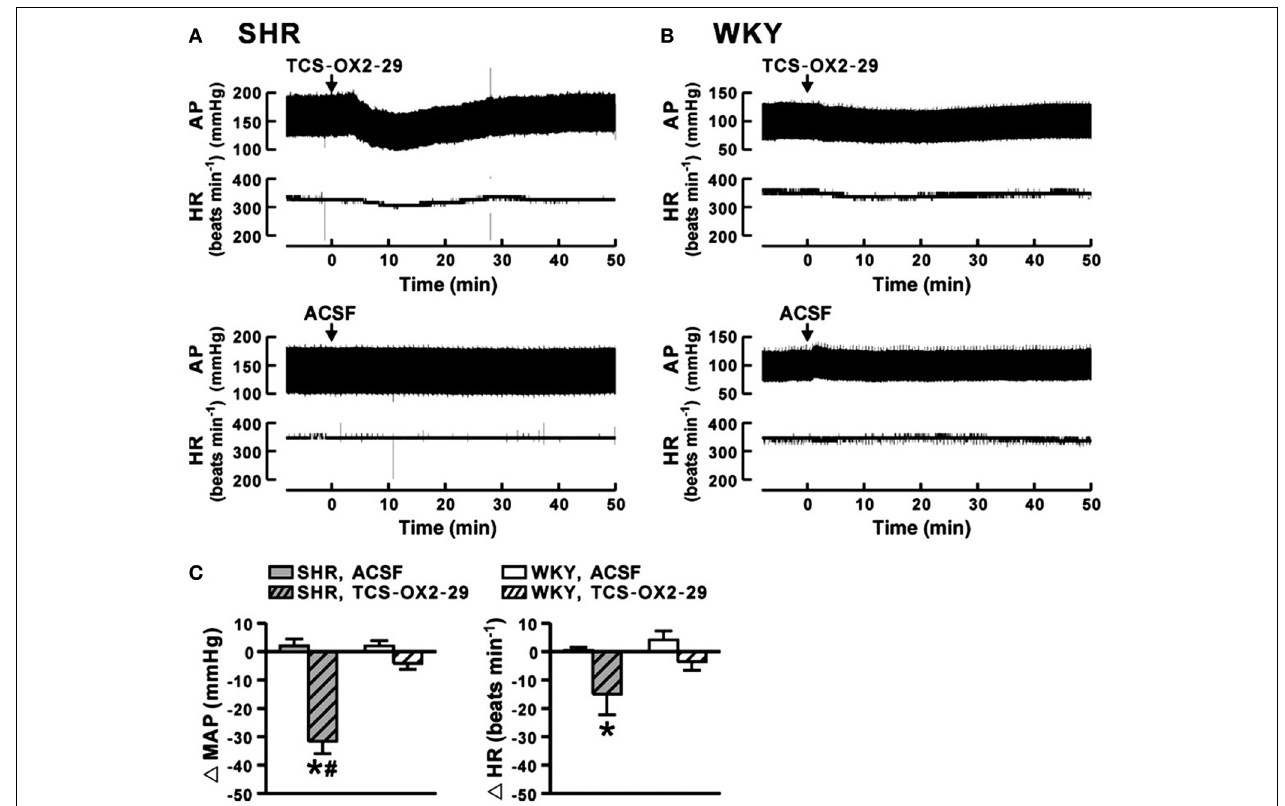
FIGURE 7 | In anesthetized SHR, antagonism of OX 2 R in RVLM decreases arterial pressure. Microinjection of an OX 2 R antagonist (TCS-OX2-29) into the RVLM significantly decreased mean AP and HR in anesthetized SHR (A,C) , and the maximum change of mean AP and HR being 30mmHg and 20bpm respectively (C, gray hatched bars). It is